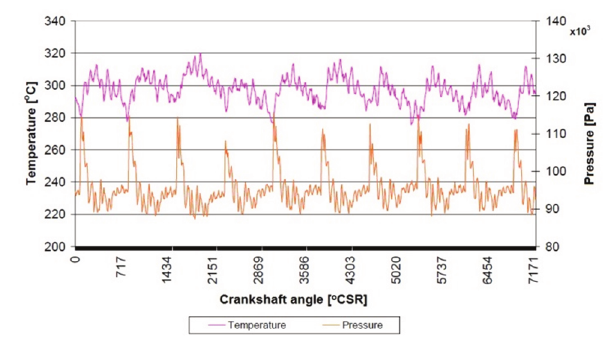
Fig. 5. Time courses of the quick changeable temperature and exhaust gas pressure obtained from ten consecutive engine cycles for state 1 – with the